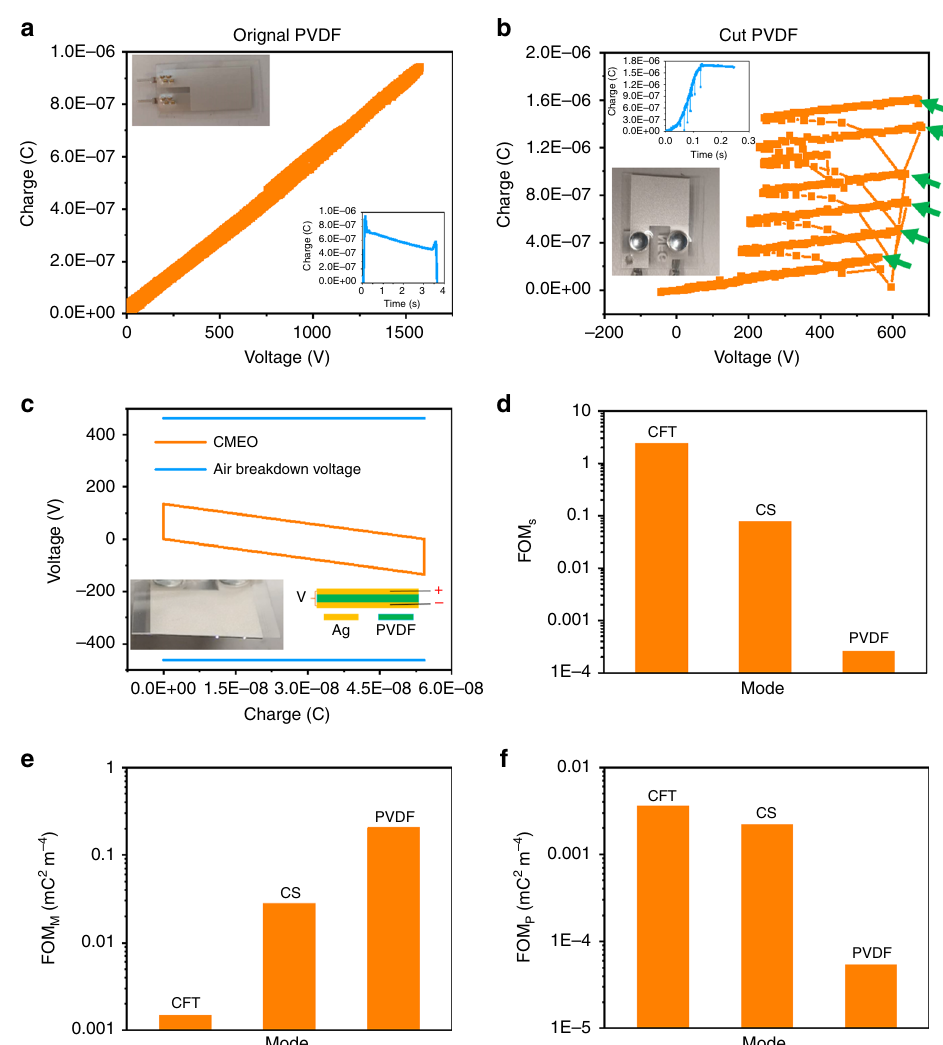
Fig. 5 Further applications of the proposed method. Q – V plots of a PVDF- fi lm-based PENG without cutting, no breakdown happens; and b PVDF piezo- fi lm after cutting, with blue lines of transfer charge and fi gures of experiment devices inset. Points targeted by green arrow in b is breakdown point. c Cycle for maximized energy with the threshold breakdown curves of PVDF fi lm after cutting with schematic diagram and fi gure with visible spark inset in. The measured structural FOM ( d ); material FOM ( e ) and performance FOM ( f ) of different structures. Source data are provided as a Source Data fi le